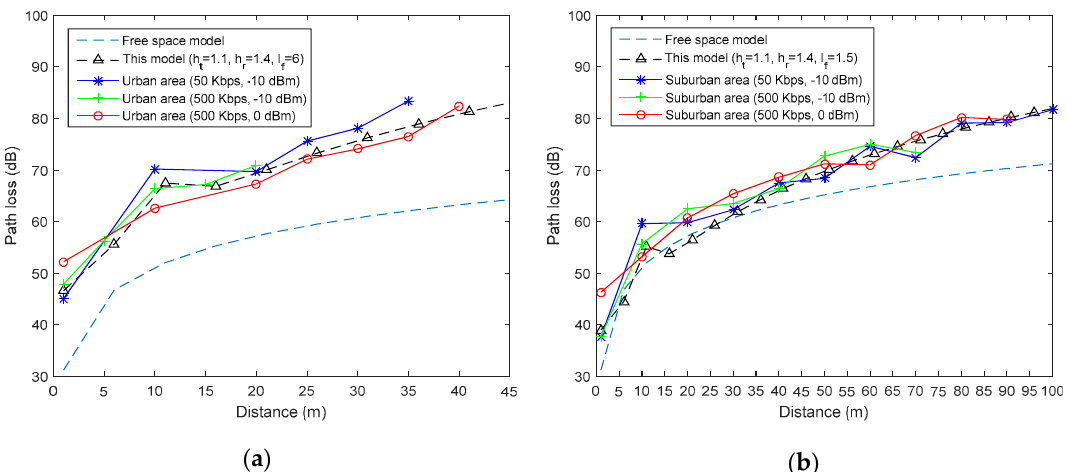
Figure 13. The measured path-loss versus the free-space and estimated ones in the ( a ) urban and ( b ) suburban areas.